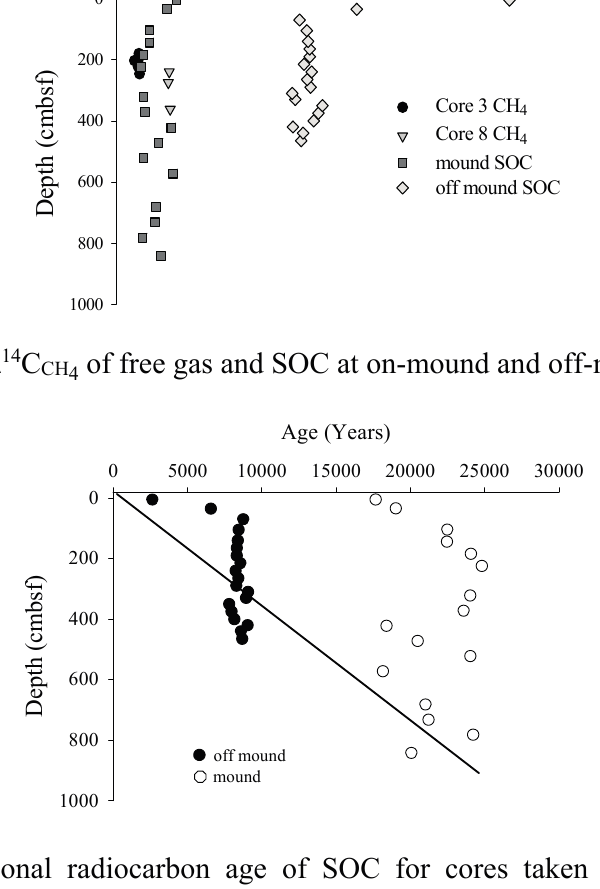
Figure 3. Conventional radiocarbon age of SOC for cores taken off- and